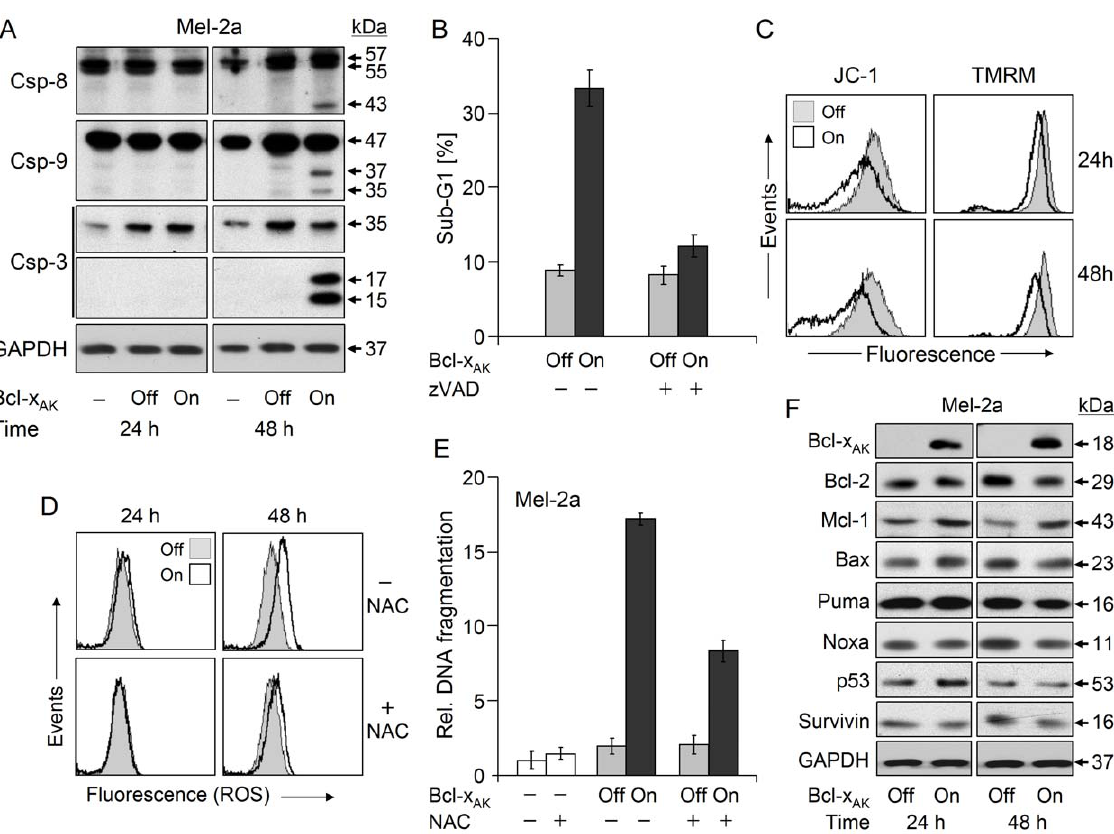
Figure 2. Activation of caspases and mitochondria. (A) Processing of caspase-3, -8 and -9 is shown in Mel-2a cells at 24 h and at 48 h after transduction with AdV-AK (MOI=50). Expression of Bcl-x AK was switched on in the absence of doxycycline (ON) or shut off with doxycycline (OFF). Equal protein loading (20 m g/lane) was confirmed by GAPDH. The whole experiment was performed twice. (B) Inhibition of apoptosis by preincubation with the pancaspase inhibitor zVAD-fmk (1 h, 10 m M) is shown. SK-Mel-13 cells had been transduced with AdV-AK (MOI=100, 48 h). Means and SDs of triplicate values of a representative experiment (one of two) are shown. (C) Decrease of the mitochondrial membrane potential ( Dy m ) is shown for Mel-2a cells at 48 h after transduction of AdV-AK, as determined by flow cytometry after JC-1 or TMRM + staining. Cultures with doxycycline (OFF, grey) are compared to cultures grown in the absence of doxycycline (ON, open graphs). The experiment was performed three times, resulting in highly comparable results. (D) ROS levels were determined in Mel-2a cells at 24 h and 48 h after transduction with AdV-AK under ON and OFF conditions (flow cytometry after H 2 DCFDA staining). Below, parallel cultures were pre-treated for 1 h with 200 m M NAC before transduction. (E) Relative DNA-fragmentation rates (apoptosis) at 48 h with or without NAC were determined in parallel. Non-transduced cells ( 2 / + NAC) are shown as additional controls (open bars). Values had been normalized with regard to non-treated controls, set to 1. Means and SDs of triplicate values of a representative experiment are shown (two independent experiments). (F) Expression levels of Bcl-2 proteins, of p53 and Survivin were determined by Western blot analysis in Mel-2a cells at 24 h and 48 h after transduction with AdV-AK (ON and OFF conditions). Equal protein loading (20 m g/lane) was confirmed by GAPDH.